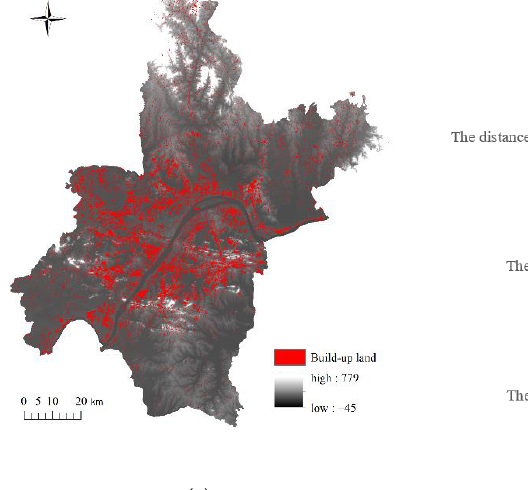
Figure 15. Importance analysis of various driving factors to the growth of built-up land. ( a ) The built-up land expansion analysis, with the most important factor overlapped. ( b ) The importance of each factor relative to the growth of built-up land.